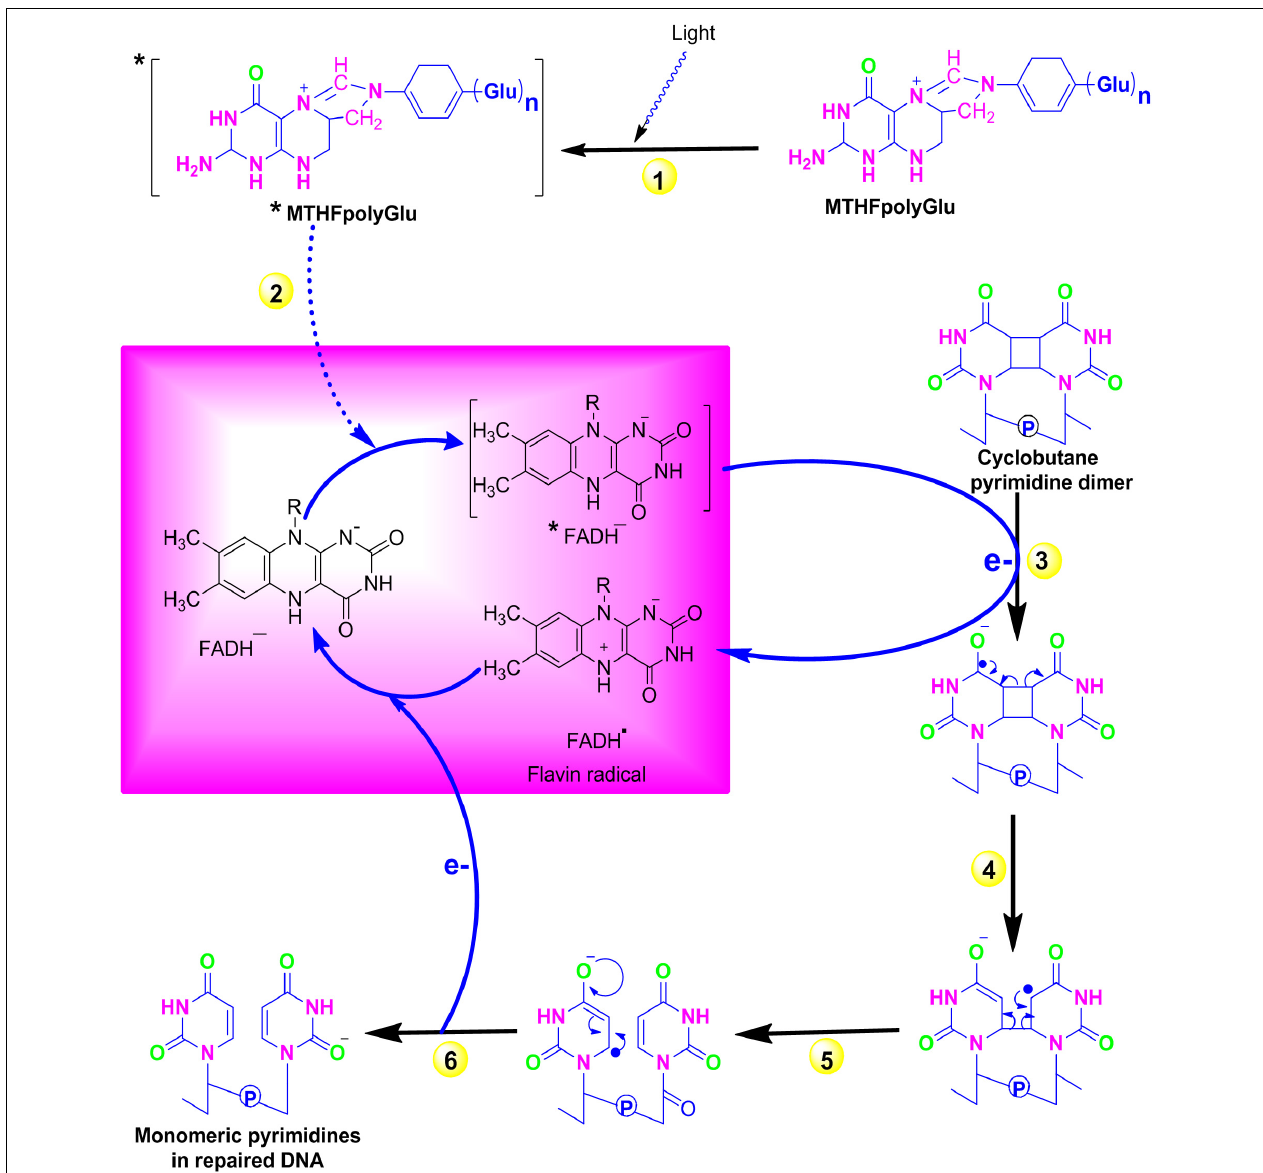
FIGURE 1 | Repair of pyrimidine dimers with photolyase. (1) A blue-light photon is absorbed by the first chromophore MTHFpolyGlu, which functions as a photoantenna. (2) The electron from the excited MTFH* is then transferred to second chromophore FADH − . (3) The excited electron from *FADH − is then transferred to pyrimidine dimer and converts it into pyrimidine monomers. (4–5) Electronic rearrangement restores the monomeric pyrimidines, and (6) the electron is transferred back to the flavin radical to regenerate FADH − . Source: Figure adapted and modified from Bray and West (2005). [MTFH ( N 5, N 10 methenyl-tetrahydro folate); FADH − (flavin adenine